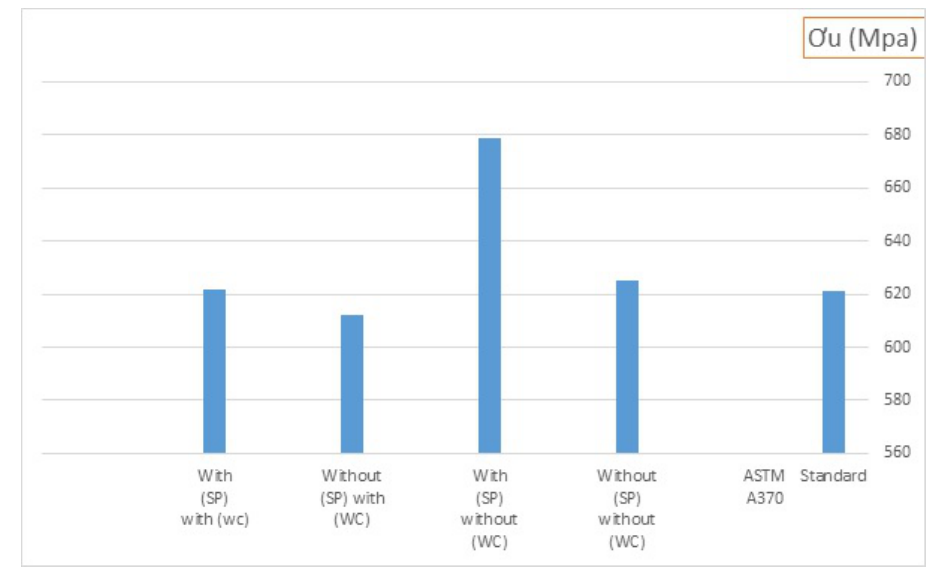
Figure 2: Experimental and the standard mechanical properties of stainless steel 304